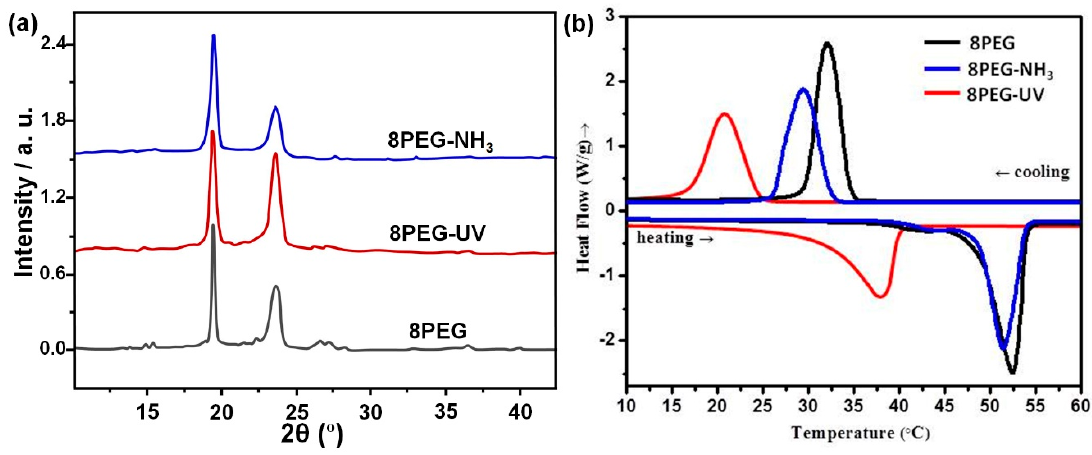
Figure 3. ( a ) WAXD patterns and representative ( b ) DSC curves of 8PEG, 8PEG–NH 3 and 8PEG–UV.